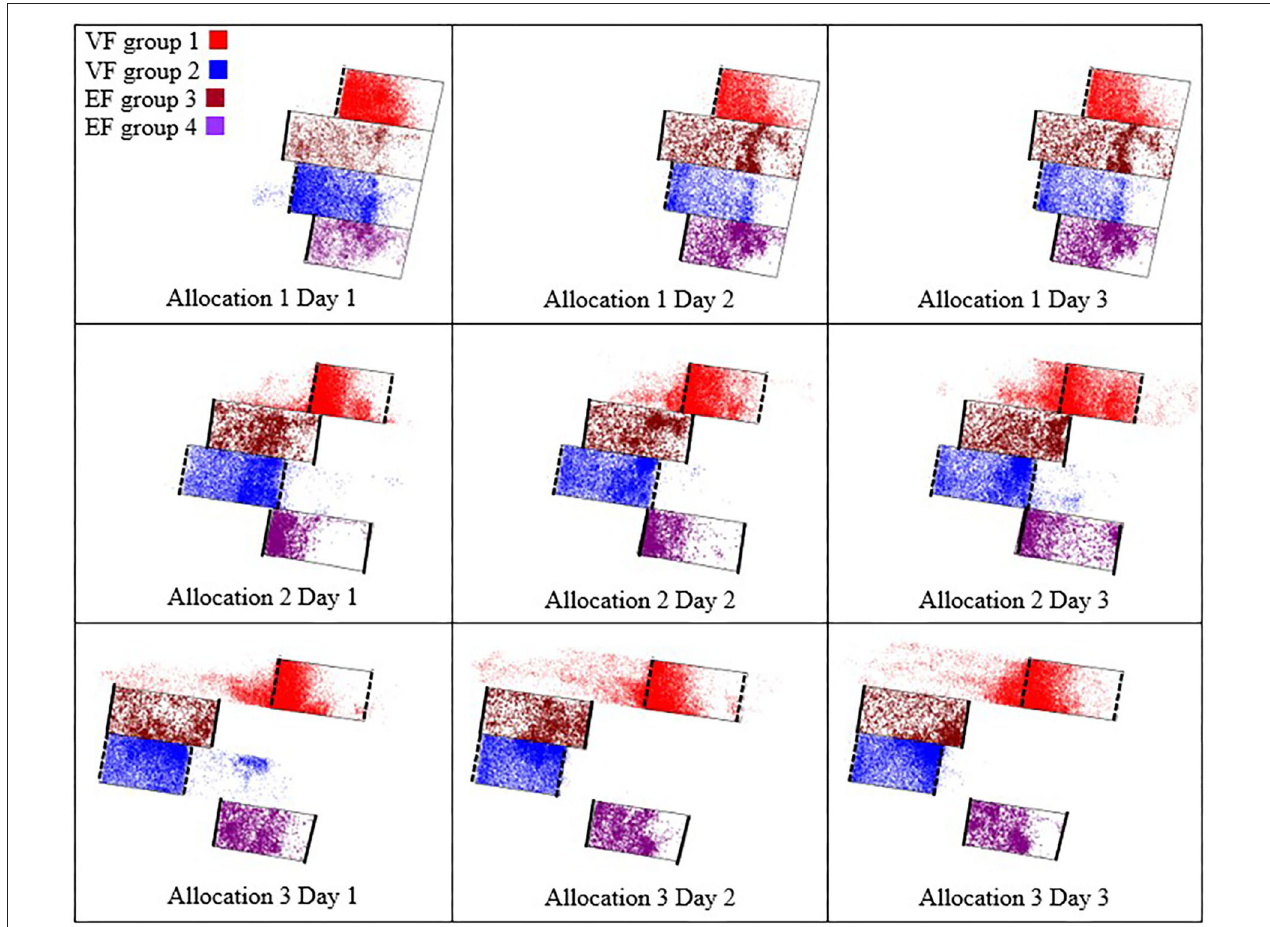
FIGURE 2 | GPS locations of cattle recorded at 10s intervals throughout each day. Left to right—day 1, 2, 3. Top to bottom—allocation 1, 2, 3. The external rectangle indicates the same relative GPS position for all days. Solid black lines indicate electric fences and dashed lines are virtual fences. GPS positions outside the boundaries of the electric fence are known to be incorrect readings and are not shown. The top left corner of each rectangle is latitude − 41.0851, longitude 145.7723. The bottom right corner is 272m east and 194m south of that